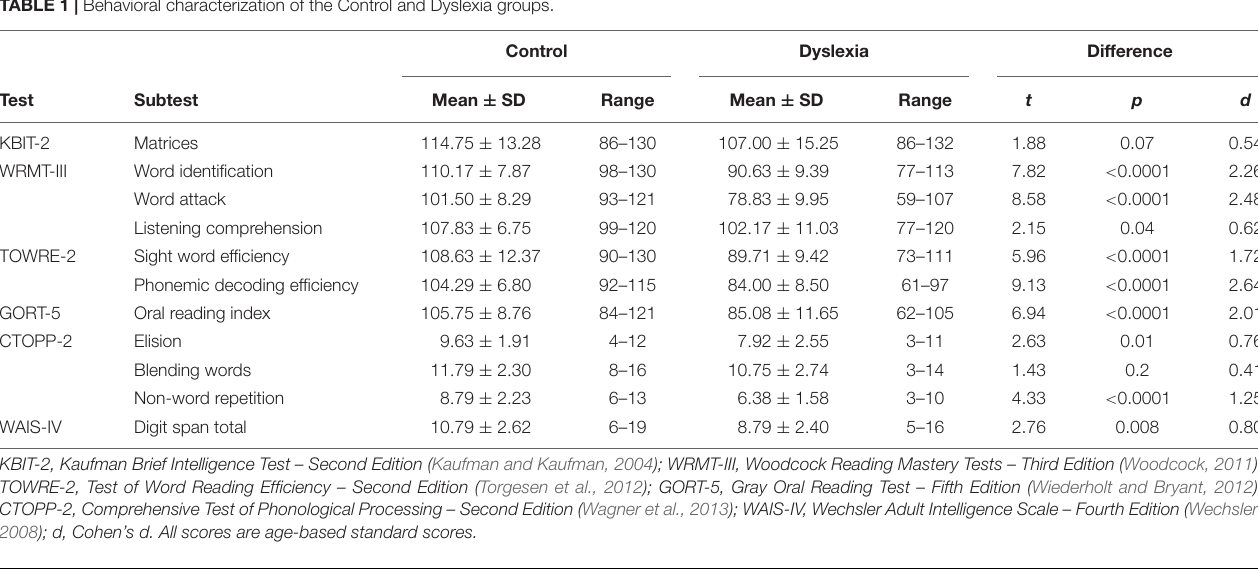
TABLE 1 | Behavioral characterization of the Control and Dyslexia